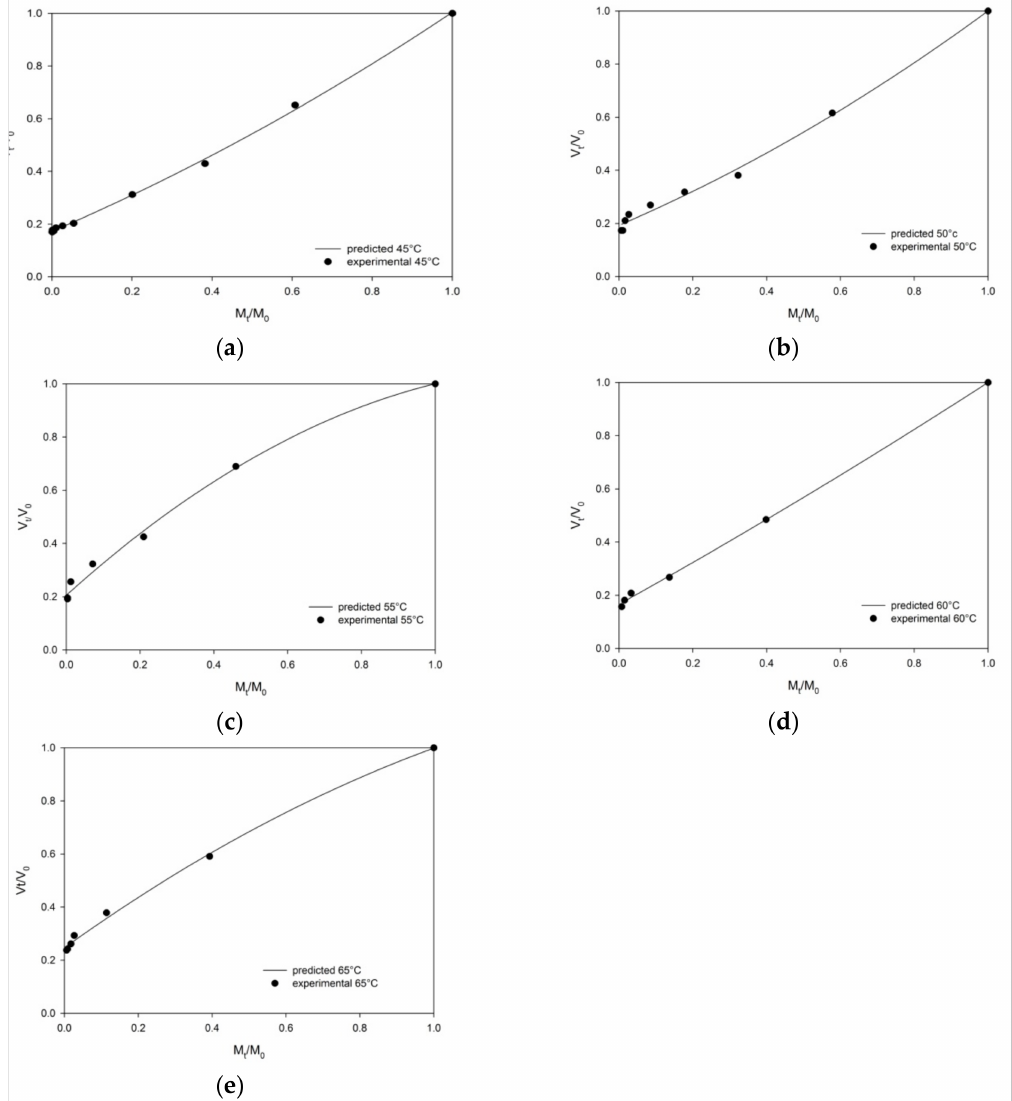
Figure 3. Experimental data (symbols) and prediction (curves) of volume shrinkage in terms of volume ratio ( V t / V 0 ) of persimmon samples during drying at ( a ) 45 ◦ C, ( b ) 50 ◦ C, ( c ) 55 ◦ C, ( d ) 60 ◦ C, and ( e ) 65 ◦